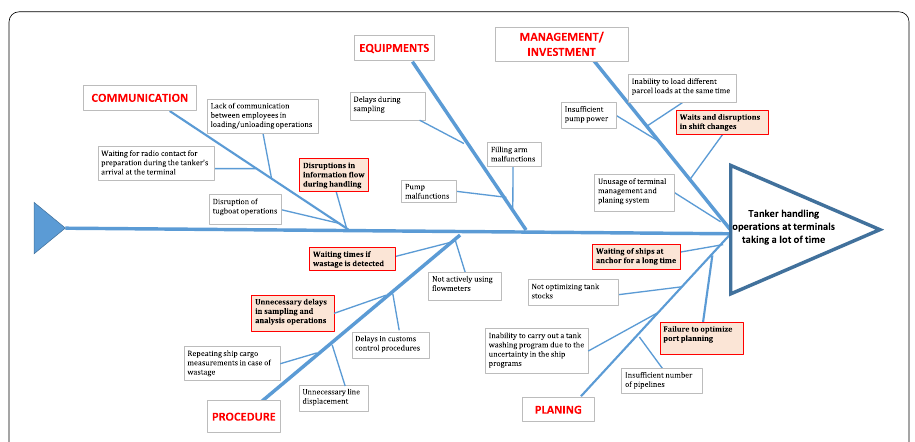
Fig. 1 Application of fishbone